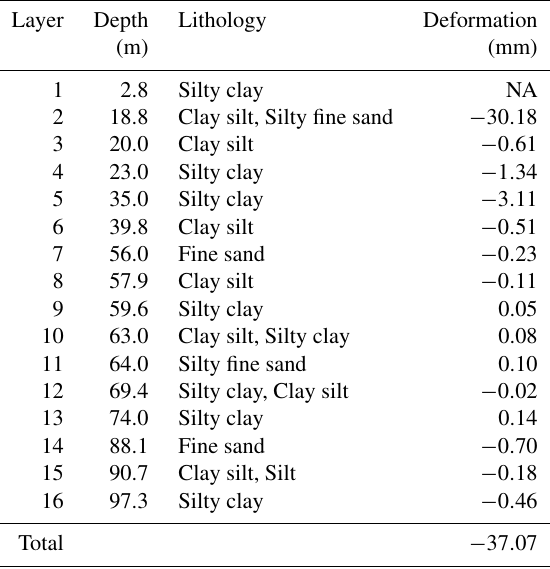
Table 1. Deformation of each stratum in